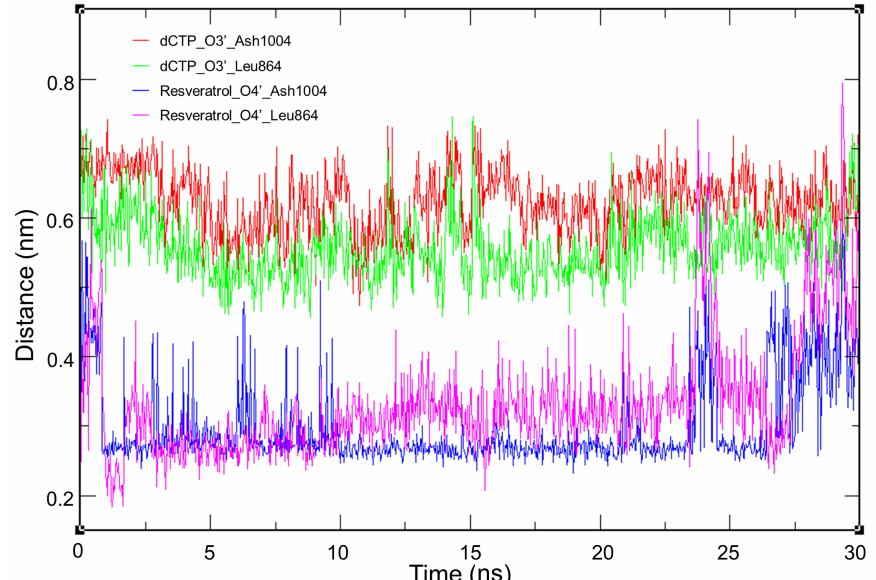
Figure 3. Minimum distance between hydrogen bond donors and acceptors on 4Q5V-ligand complex during MD simulation. The red line indicates the distance between 3 (cid:48) -OH of dCTP and Ash1004; the green line indicates the distance between 3 (cid:48) -OH of dCTP and Leu864; the blue line indicates the distance between 4 (cid:48) -OH of resveratrol and Ash1004; the pink line indicates the distance between 4 (cid:48) -OH of resveratrol and